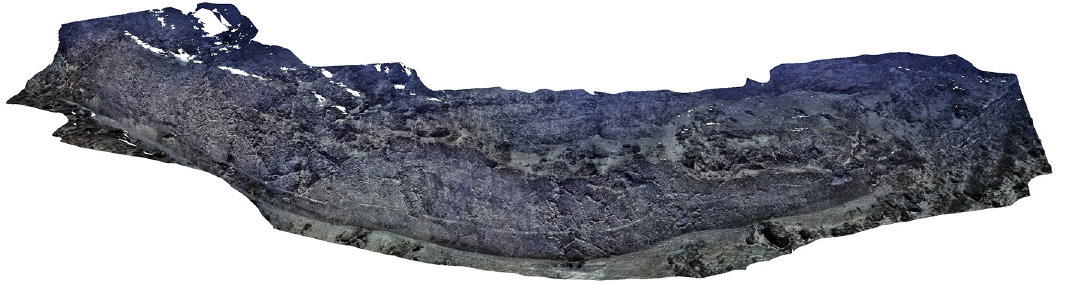
Figure 12. Textured 3D model of FPA